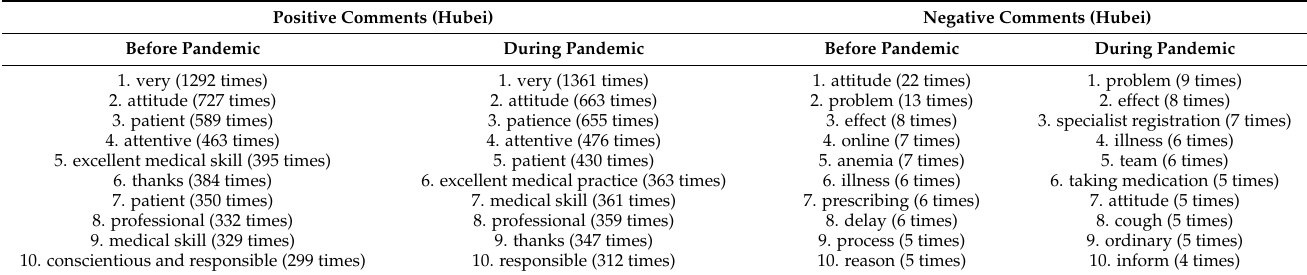
Table 7. Frequently Used Words in Comments (Hubei).